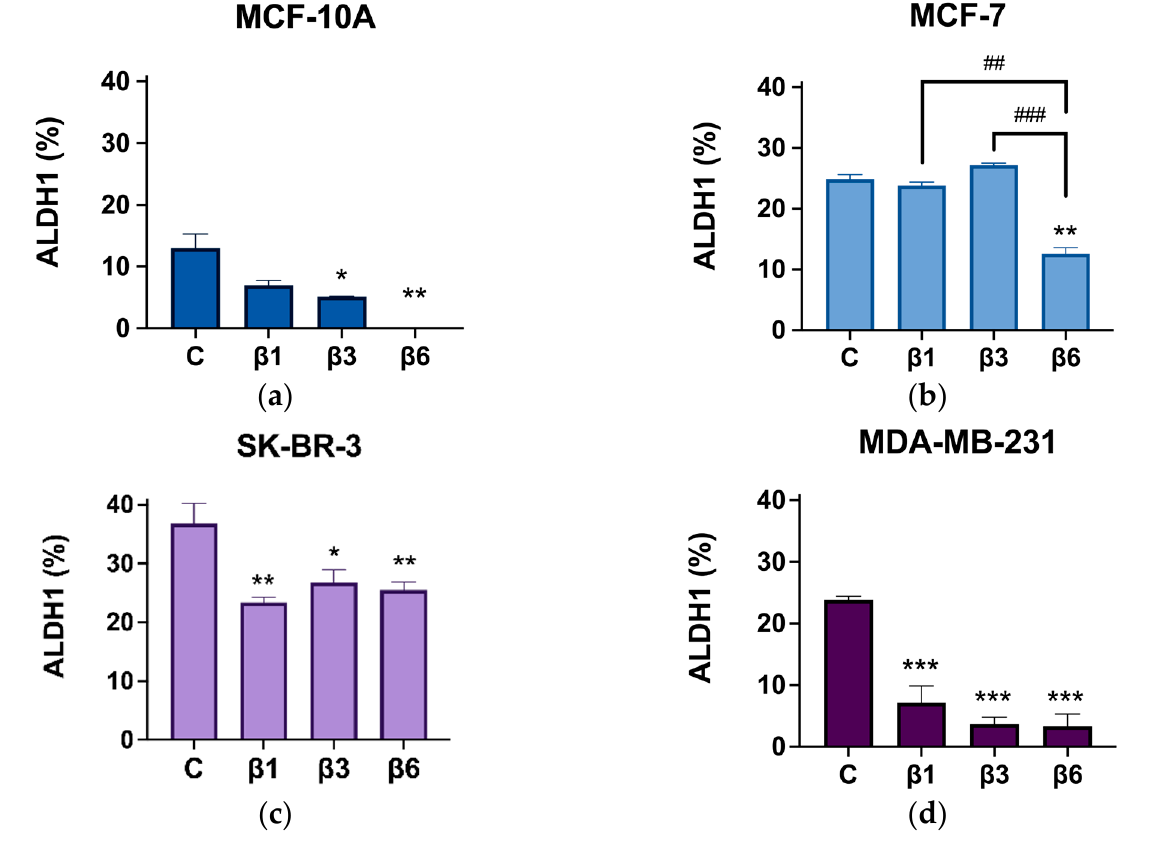
Figure 6. ALDH1 activity after treatment with β 1-conglutin (2.5 ng/µL), β 3-conglutin (5 ng/µL), or β 6-conglutin (10 ng/µL) for 24 h in ( a ) MCF10-A, ( b ) MCF-7, ( c ) SK-BR-3, and ( d ) MDA-MB-321. After 24 h of ( a ) β 1, ( b ) β 3, and ( c ) β 6-conglutin treatment, cells were incubated with BODIPY-aminoacetaldehyde (BAAA), a fl uorescent non-toxic substrate for ALDH, which was converted into BOD- IPY-aminoacate (BAA) and retained inside the cells. The speci fi c inhibitor of ALDH, diethylamino- benzaldehyde (DEAB), was used to control for background fl uorescence. Viable ALDH1+ cells were quanti fi ed by fl ow cytometry on a BD FACS Aria IIIu Flow Cytometer (Becton Dickinson, BD Bio- science). * p < 0.05, ** p < 0.01, and *** p < 0.001 vs. non-treated cells, and ## p < 0.01, and ### p < 0.001 vs. other treatments.